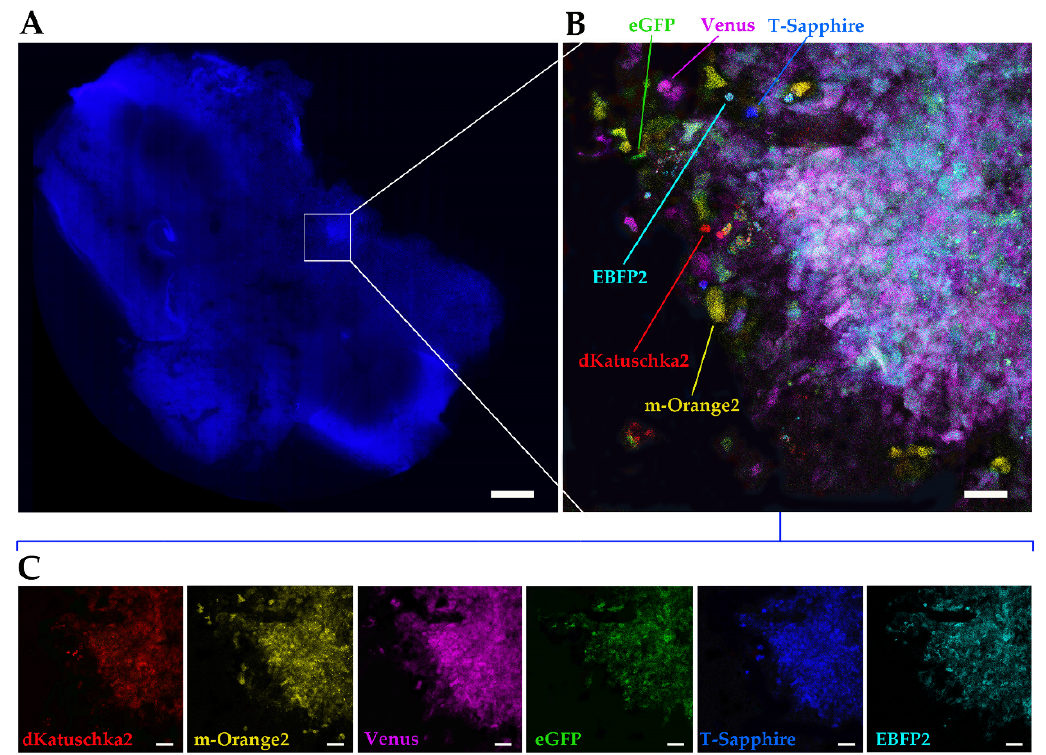
Figure 9. Multifluorescent ex vivo 3D tumor invasion on OBSc. ( A ) Hoechst staining of a representative whole brain organotypic slice cultures (OBSc), encompassing pons and medulla, was acquired at a digital slide scanner (Nanozoomer S60, Hamamatsu). ( B , C ) Representative images of multifluorescent bulk OPBG-DIPG002 cell invasion on cleared OBS are shown. Images were acquired on a Leica AOBS-SP8X confocal microscope, after tissue clearing to reduce brain tissue autofluorescence. Overlay confocal image ( B ) showing single fluorescent scattered cells propagating outside the central area. The fluorescence of invading cells is shown also on the split panel ( C ) in red (dKatushka2), yellow (m-Orange2), magenta (Venus), green (eGFP), blue (T-Sapphire) and cyan (EBFP2) channels. Scale bars: 1mm in ( A ), 50 µ m in ( B , C ).